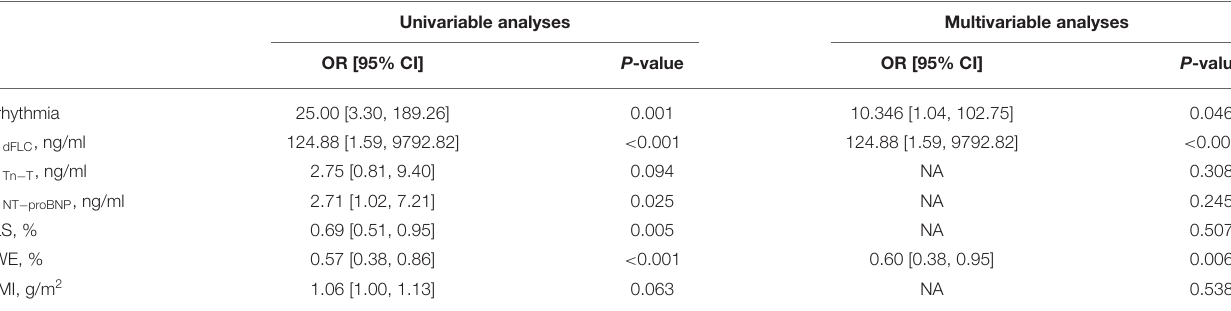
TABLE 5 | The multivariable regression analyses of risk factors contributing to CAEs in patients with MM. Univariable analyses Multivariable analyses OR [95% CI] P -value OR [95% CI] P